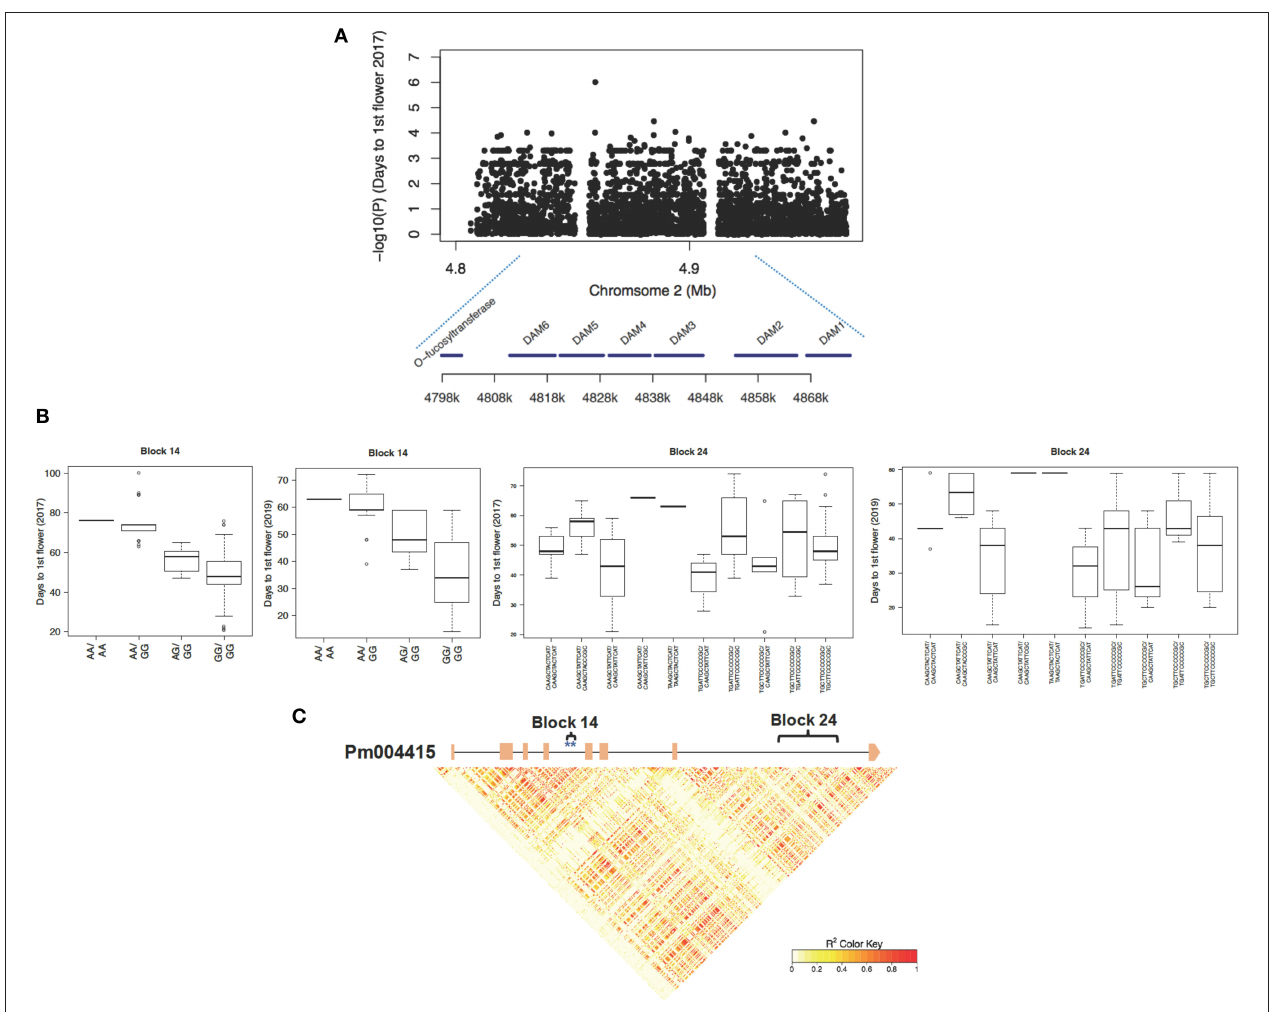
FIGURE 4 | The DORMANCY-ASSOCIATED MADS-BOX ( DAM ) gene containing a region associated with timing of blooming in 2017 and 2019. (A) Snapshot of SNP-trait associations with timing of the first flower in 2017. (B) Haplotypes within Pm004415 ( DAM6 ) exhibiting a correlation with timing of the first flower in 2017 and 2019. (C) The local linkage structure among SNPs within the 2Kb upstream/downstream region of Pm004415. Exons of gene Pm004415 were symbolized with orange squares and associated SNPs were labeled with blue